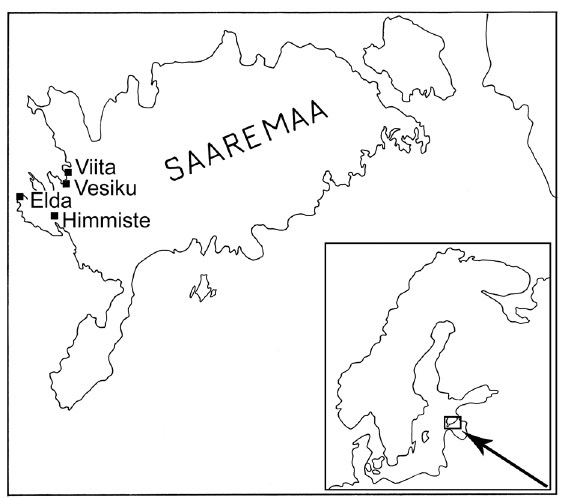
Fig. 1. Location of Viita, Vesiku, Elda and Himmiste outcrops on Saaremaa Island in Western